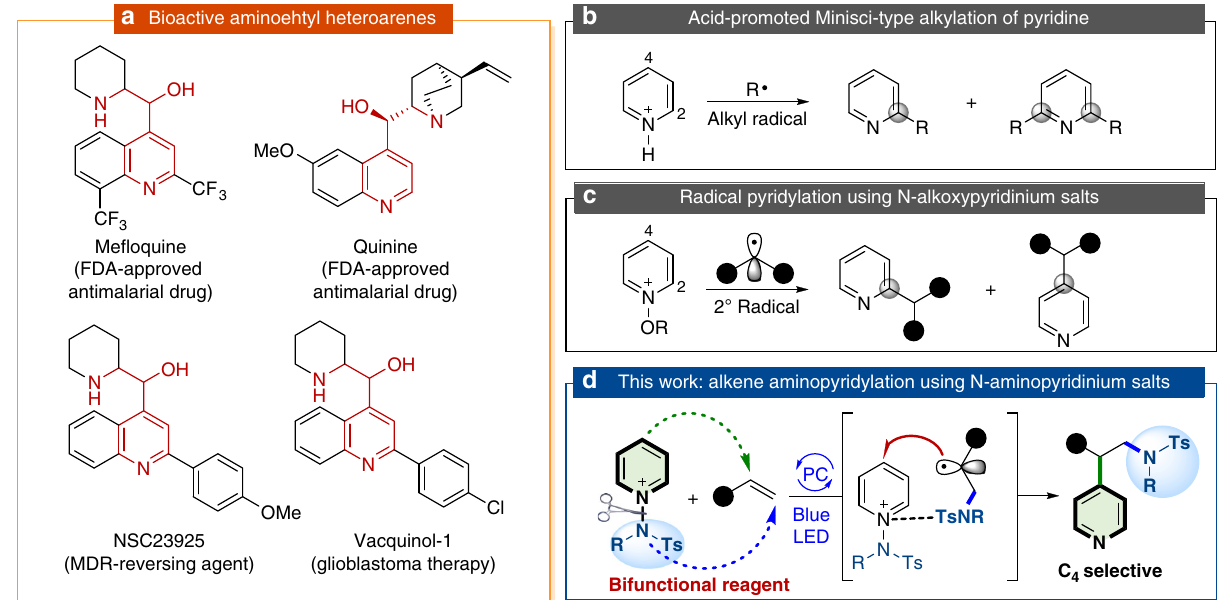
Fig. 1 Project background and design plan for photocatalytic aminopyridylation of ole fi ns. a Bioactive aminoethyl heteroarenes. b Minisci-type alkylation of pyridine core. c Radical pyridylation using N-alkoxypyridinium salts. d Aminopyridylation of ole fi ns using N-aminopyridinium salts as bifunctional reagents. PC photocatalyst. Ts